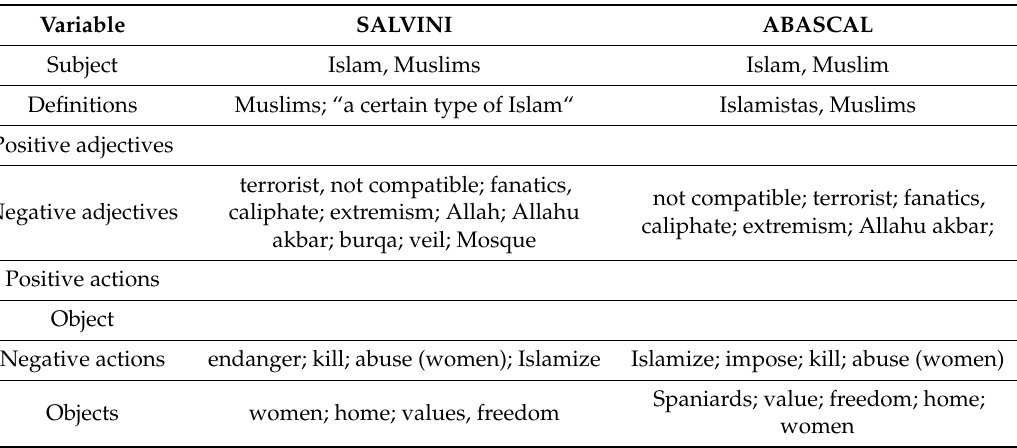
Table 3. Muslims and